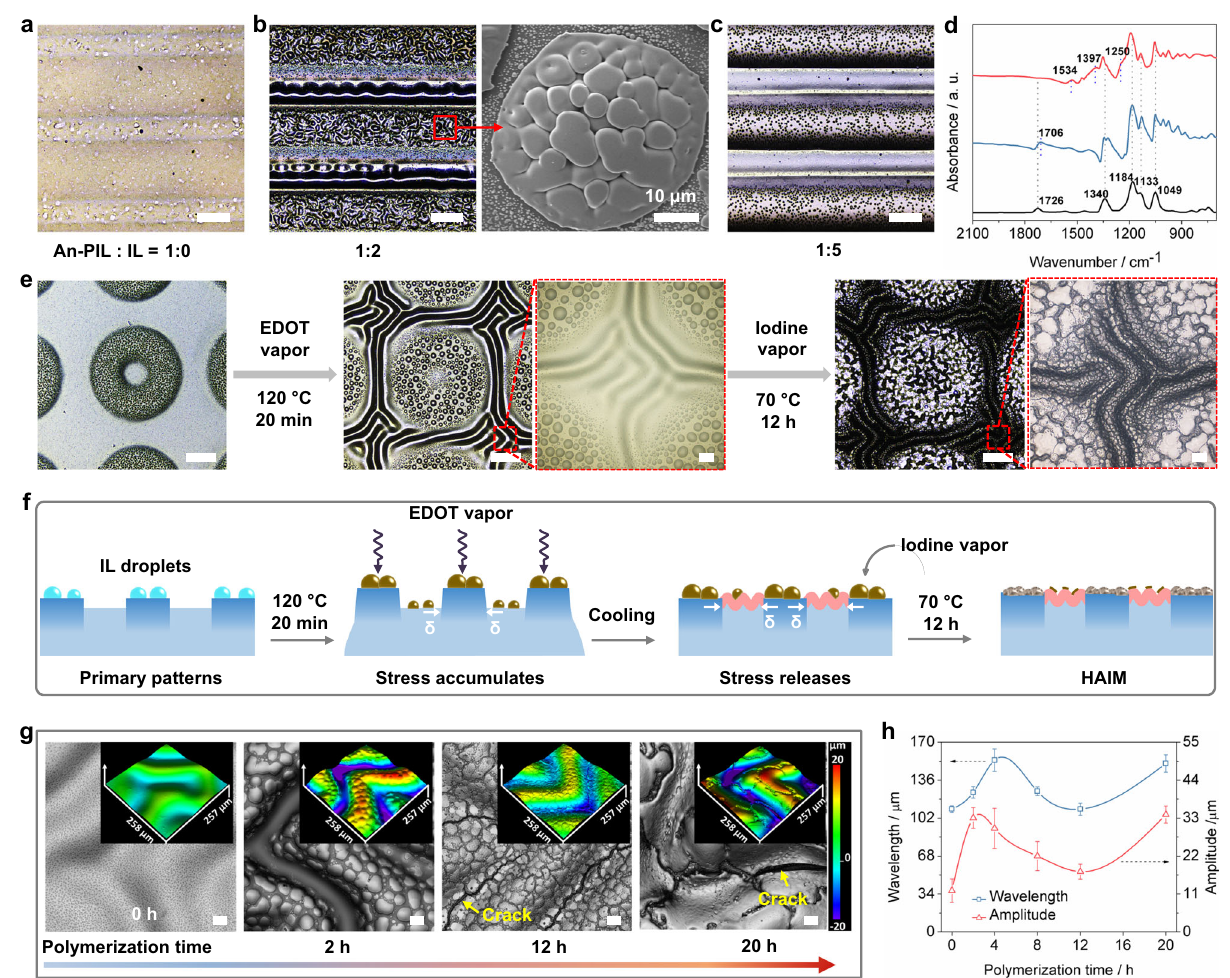
Fig. 4 | Fabrication, characterization, and mechanisms of secondary wrinkles formation.a – c OpticalmicroscopyimagesofPEDOTsynthesizedonthesurfaceof primary patterns containing different molar ratios of An-PIL to IL, scale bar: 200 μ m. d FTIR spectra for the pristine iontronic host (black line), IL droplets @primary patterns (gray-blue line), and the resultant IL-doped PEDOT @primary patterns (red line). e Optical microscopy images of the morphology variations for fabrication of the secondary wrinkles, scale bar: 200 μ m, scale bar of enlarged